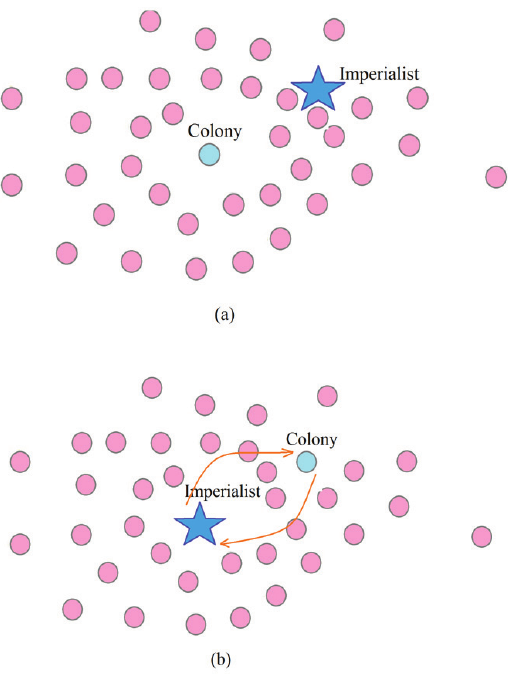
Figure 6. a: Exchanging the positions of a colony and the imperialist; b) The entire empire after position exchange.